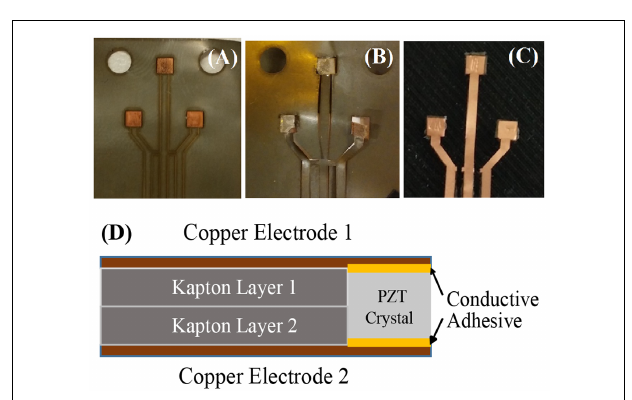
FIGURE 2 | 3-Pixel PZT sensor layer composition . The copper–kapton sheet is engraved using a micro-UV laser to facilitate electrical contact with PZT material (A) . Conductive adhesive tape is attached to bond the PZT crystal (B) . The same process is repeated for another copper–kapton